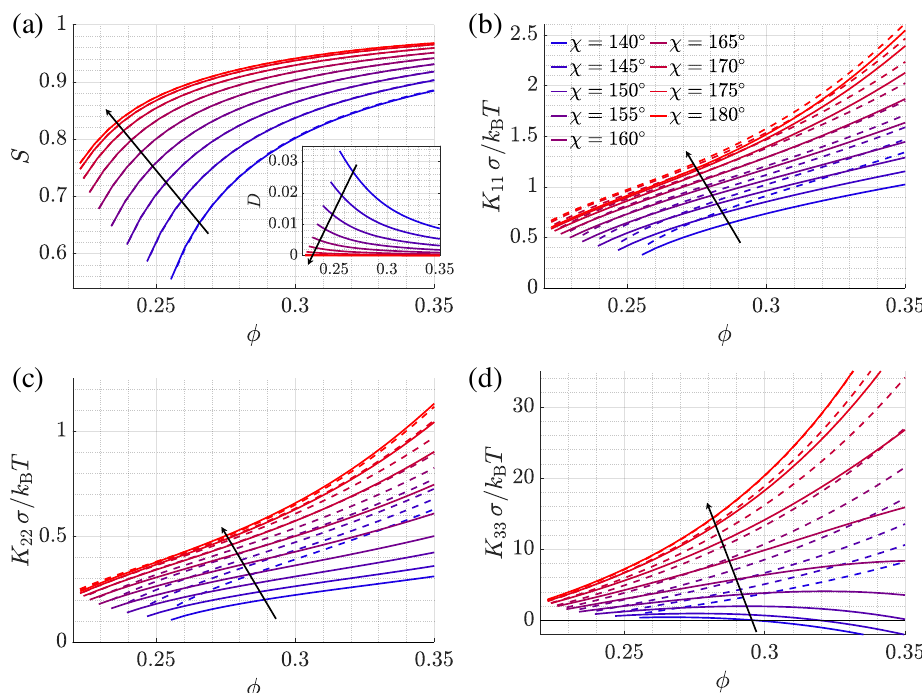
Figure 7. ( a ) Order parameters S and D (inset), and ( b ) splay, ( c ) twist and ( d ) bend elastic constant, as a function of the volume fraction φ . Values obtained using the non-local form of the ODF, Equation (5) (solid lines), and the local uniaxial form, Equation (6) (dashed lines), for the nematic phase of obtuse angle V-shaped particles with different values of the bend angle.